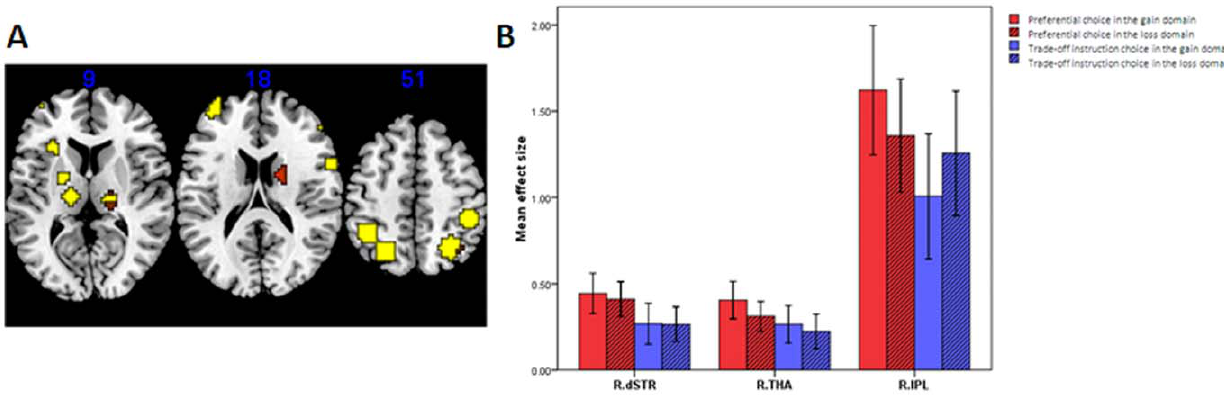
Figure 5. Differences in the activation extent in the seed regions of the functional connectivities. (A) Clusters showing the differences in activation extent are in red, and the seed regions for the functional connectivities are in yellow. (B) The parametric estimates of these clusters showing the differences in activation extent during each task condition are also shown. Abbreviations: see Table 1.